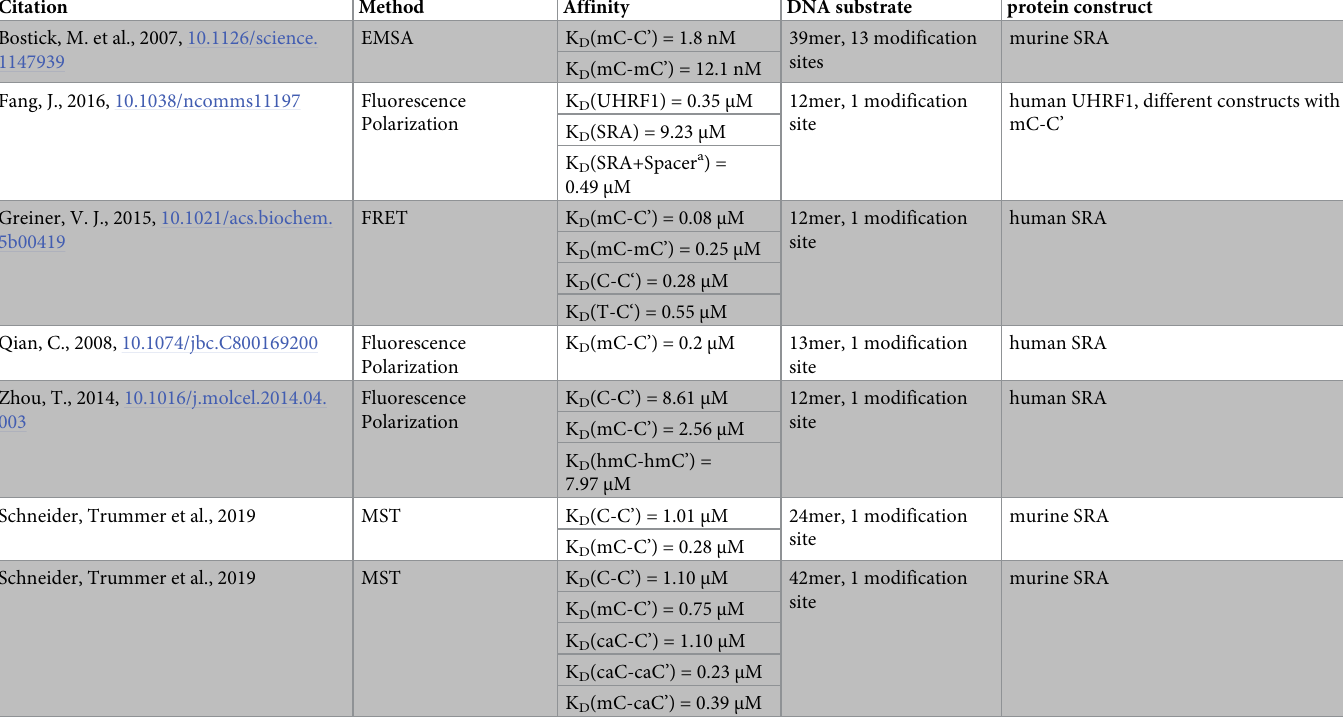
Table 1. Published K D values for UHRF1 and DNA with differentially modified CpG